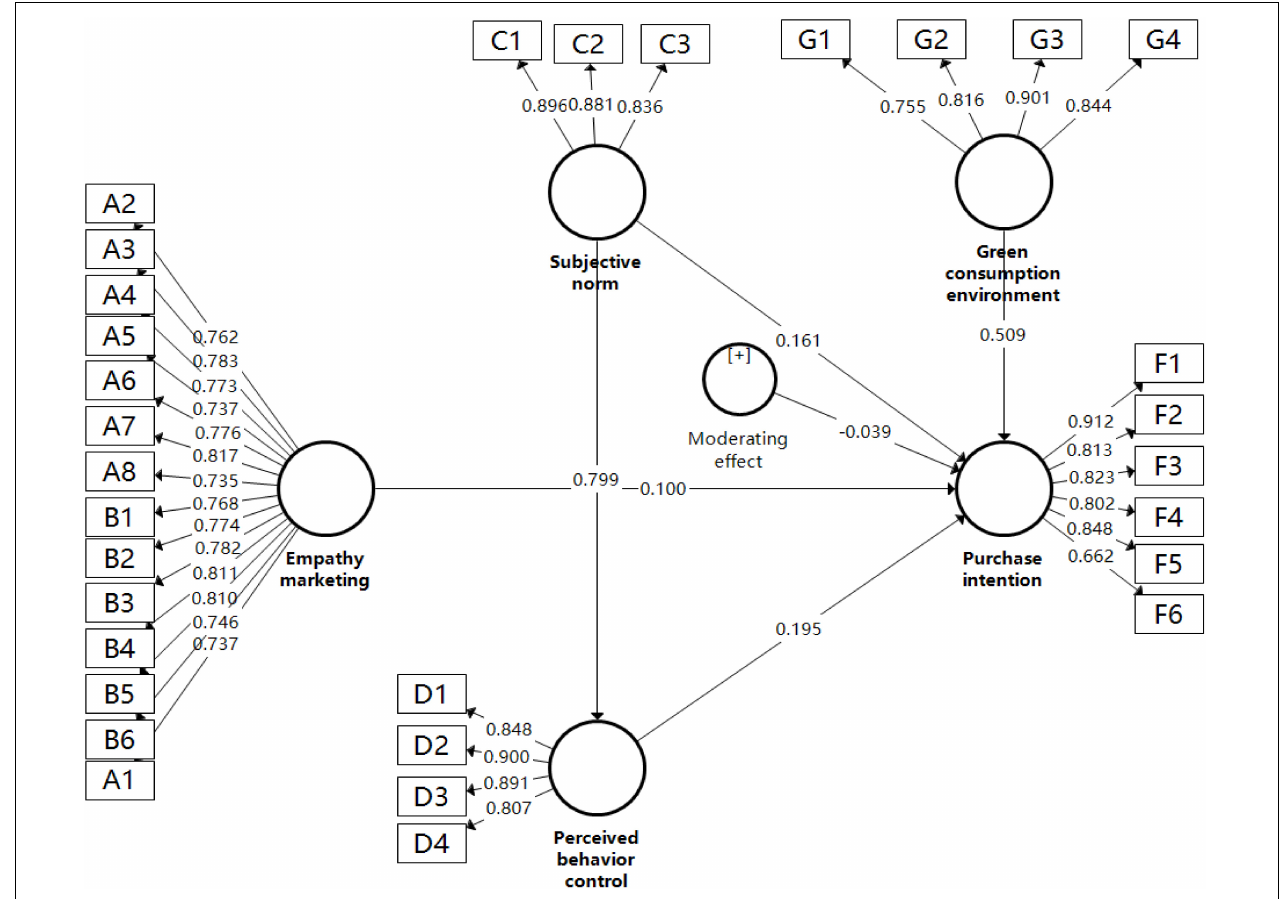
FIGURE 3 | Measurement model analysis.